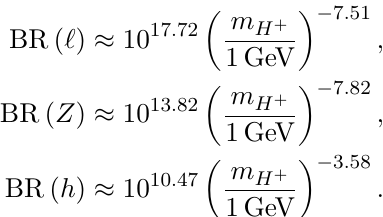
Figure 6 . The decay rates versus the mass of the charged scalar m kept at their values of benchmark point 1 in table 3. The vertical dashed lines mark m The oblique dashed lines are given by eqs.